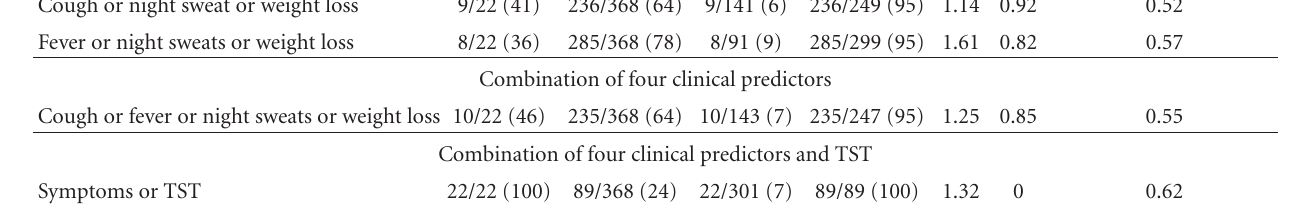
∗ ROC curve: receiver operating characteristic